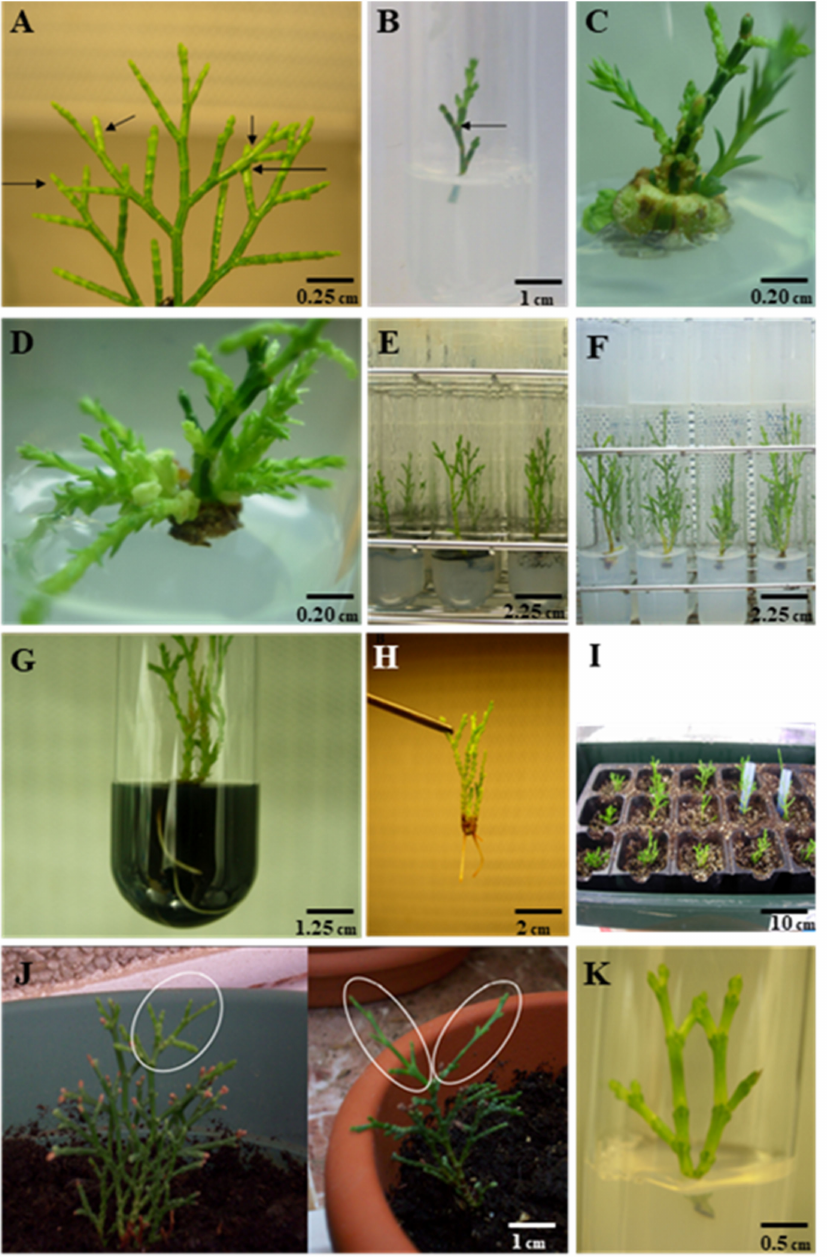
Figure 1. Tetraclinis articulata (Vahl) Masters in vitro propagation through apical shoots from adult trees. ( A ) Branches of growing individuals used as starting materials. Arrows indicate the buds taken as explants for in vitro culture initiation. ( B ) Initiated explants showing signs of growth restoration after the sterilization scheme applied ( C ) Morphogenic response of T. articulata explants cultured in vitro in Schenk and Hildebrandt (1972) (SH) medium supplemented with 30 g L − 1 sucrose